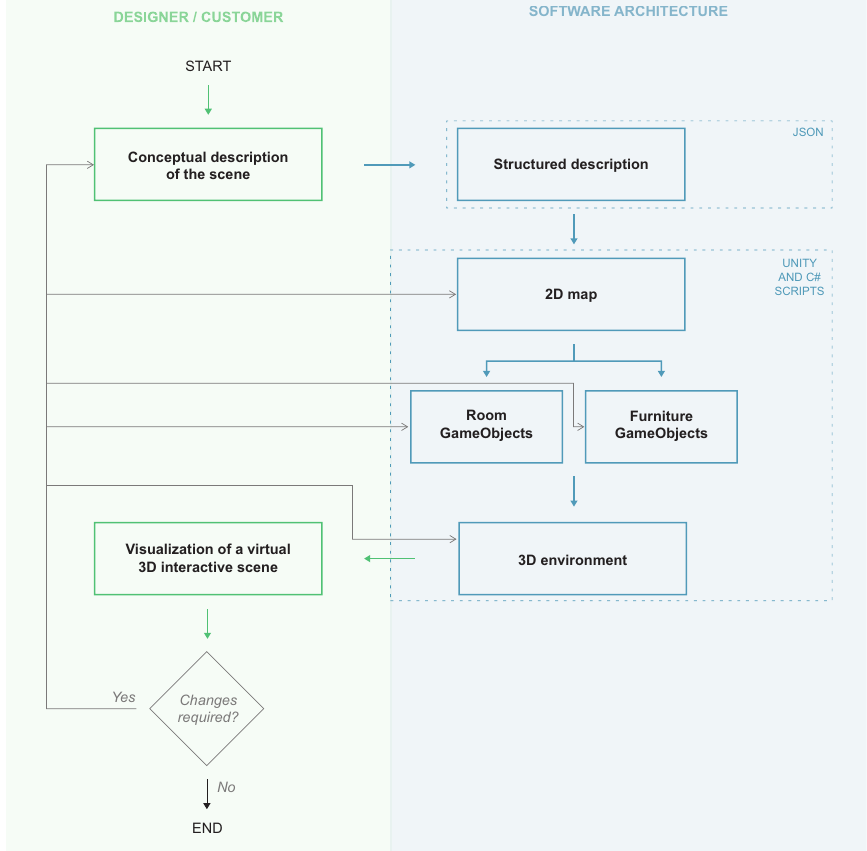
Figure 2. Block diagram of VR-based rapid prototyping of the